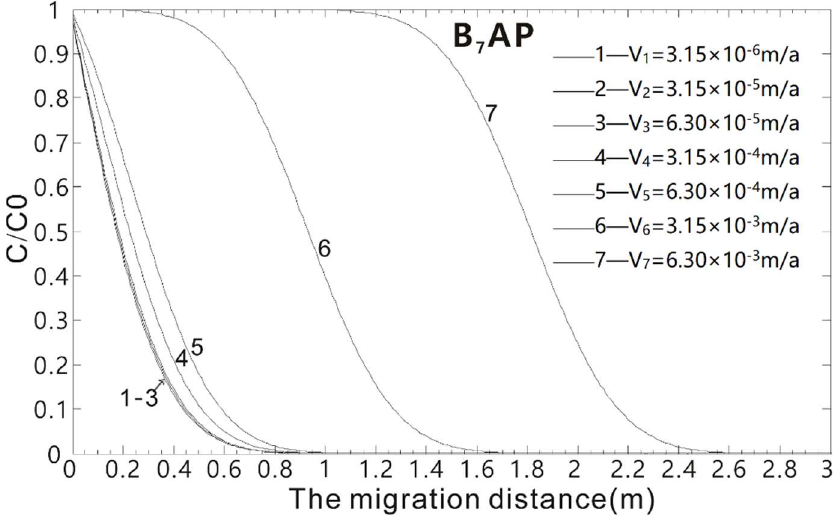
Figure 5. Effect of seepage velocity on migration of uranium in B 7 AP buffer material (t = 1000 a) .